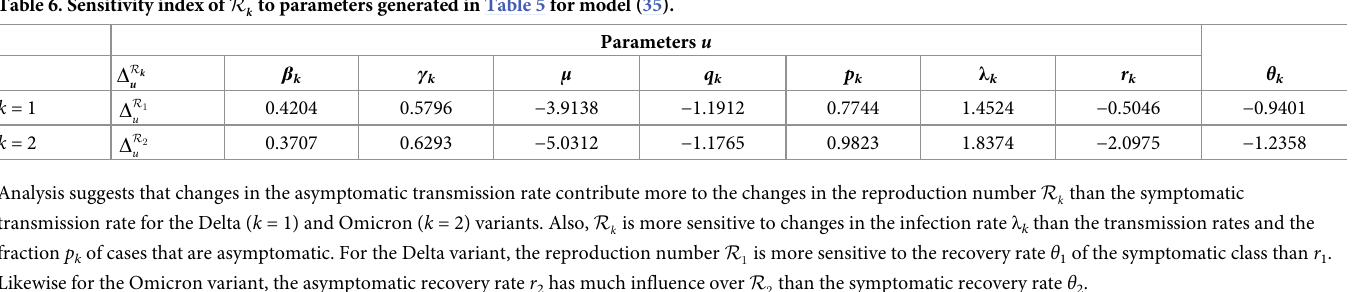
Table 6. Sensitivity index of R